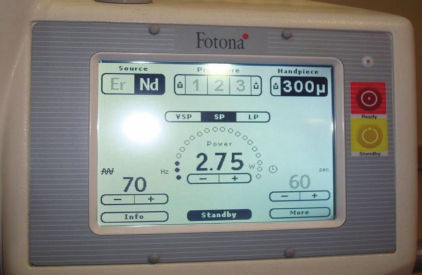
Figure 1: Intraoral photograph of amlodipine-induced gingival overgrowth.